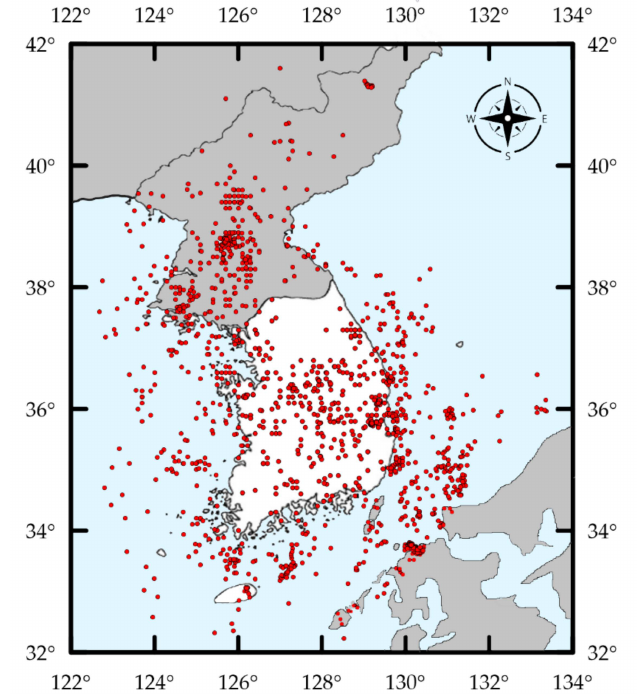
Figure 9. Epicenters of earthquakes in the compiled catalog for South Korea.